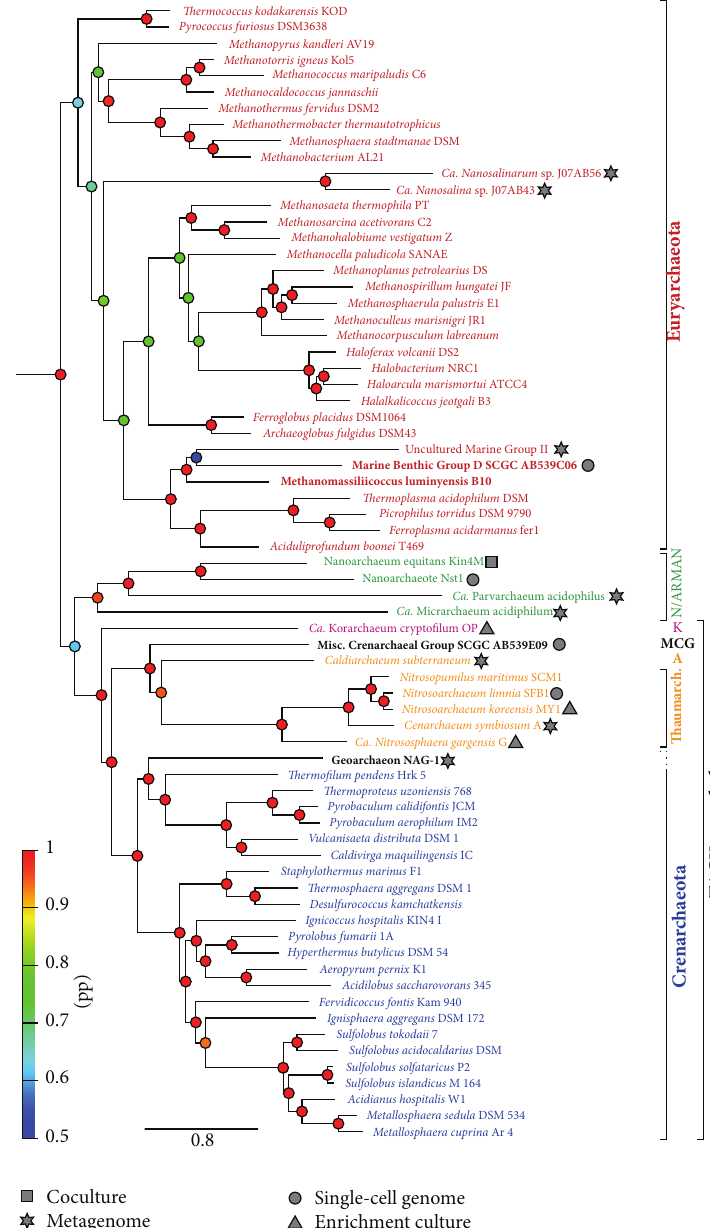
Figure 1: Bayesian phylogeny of 80 representative archaeal species. BLAST databases containing the proteome of 6 new archaeal genomes were retrieved from NCBI (in bold font on the tree): Methanomassiliicoccus luminyensis B10 (acc. no. CAJE01), MCG SCGC AB539E09 (acc. no. ALXK01), Marine Benthic Group D (MBGD) SCGC AB539N05, AB539C06, and AB540F20 (acc. no. ALXL01, AOSH01, and AOSI01, resp.). Protein sequence alignment from the 57 clusters in the discFilter 15p dataset from [70] for which eukaryotes were removed were used as an input to psi-blast, with the six new proteomes as a database. Orthologs were retrieved as in [70]. For the three MBGD strains, one composite set of orthologs was constituted by using the most complete one (AB539C06) whenever possible and complementing with sequences from the other two if available. Orthologous genes selection, alignment, trimming, and concatenation were performed as in [70] resultingina15,069amino-acidalignment.FourchainsofBayesianphylogenieswererunwithPhylobayes[71],undertheCAT-Poissonmodel, running for approximately 10000 generations and discarding half as a burn-in. The tree was rooted with bacteria. Posterior probabilities (pp) are represented by colored dots on the nodes, with support values coloured according to the depicted heat-map colour scheme. The scale represents the number of substitutions per site. Species are colored according to the following: red, Euryarchaeota; green, Nanoarchaeota (N) and ARMAN; pink, Korarchaeota (K); black, Misc. Crenarchaeal Group (MCG); orange, Thaumarchaeota and Aigarchaeota (A); blue, Crenarchaeota. The DNA collection method, if different from pure culture, is indicated by a symbol next to the organism name: square, coculture; star, metagenome; circle, single-cell genome; triangle, enrichment